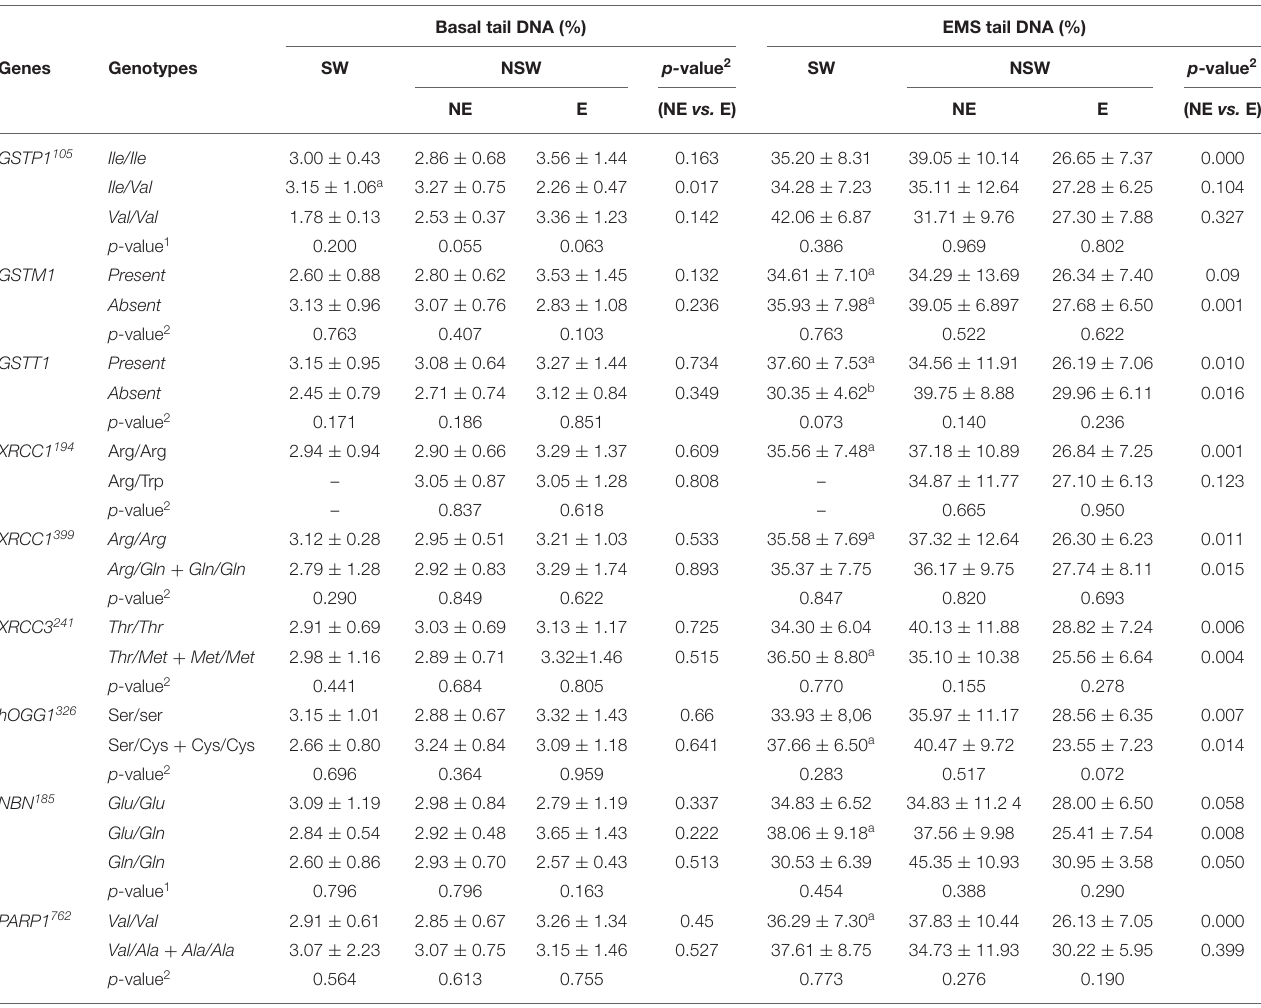
TABLE 6 | Mean ( ± SD) values for basal and EMS tail DNA in the studied groups stratified by genotypes. Basal tail DNA